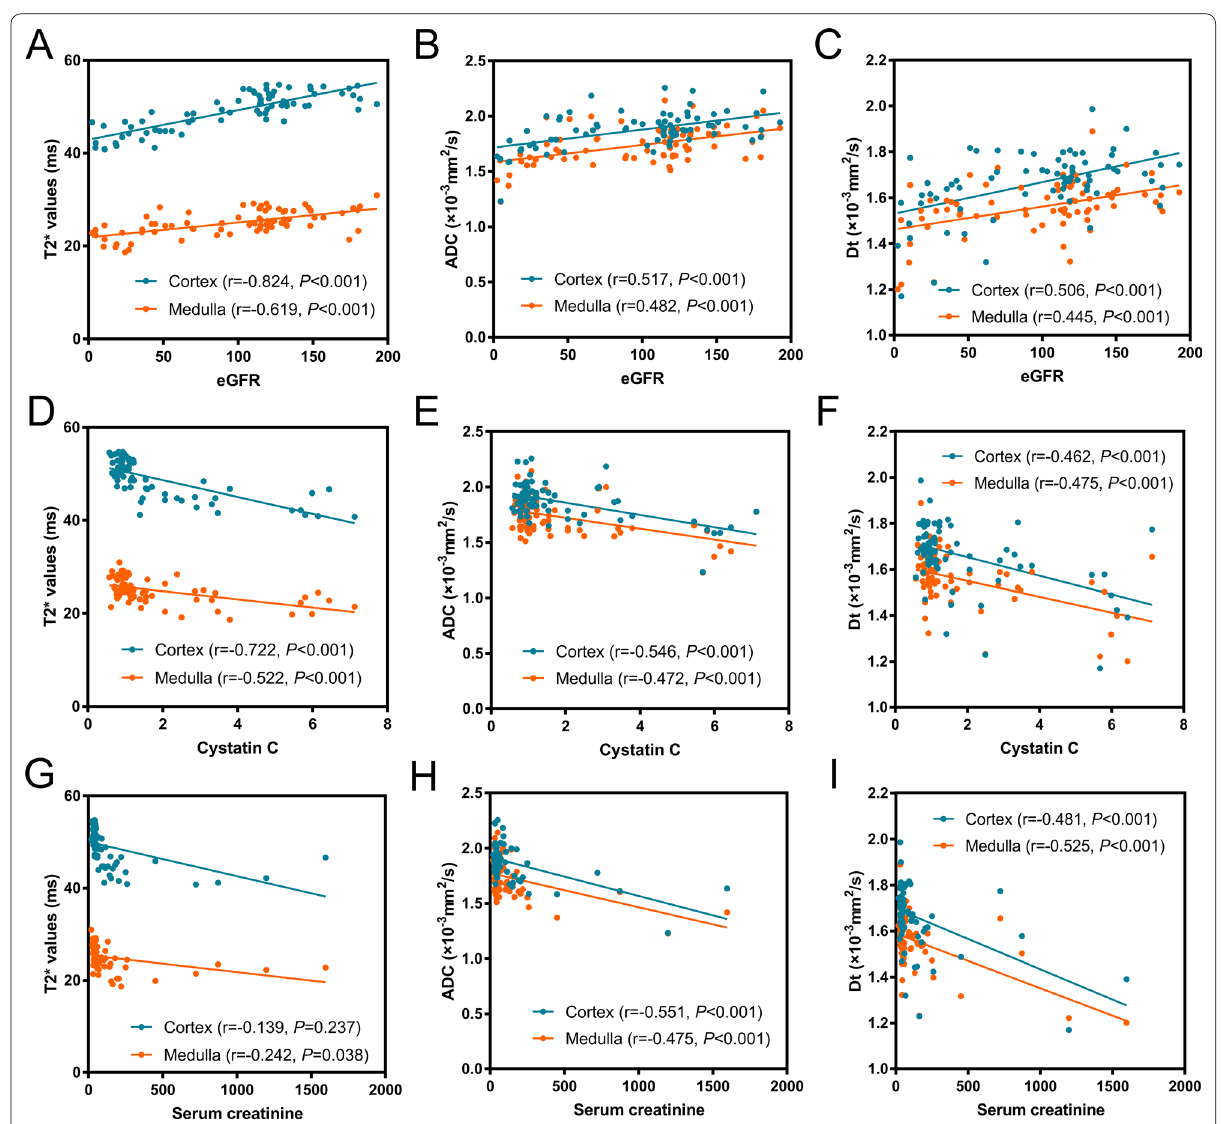
Fig. 6 Correlation of clinical data (eGFR, Cystatin C, and serum creatinine) and MRI- derived parameters (T2*, ADC, and D t